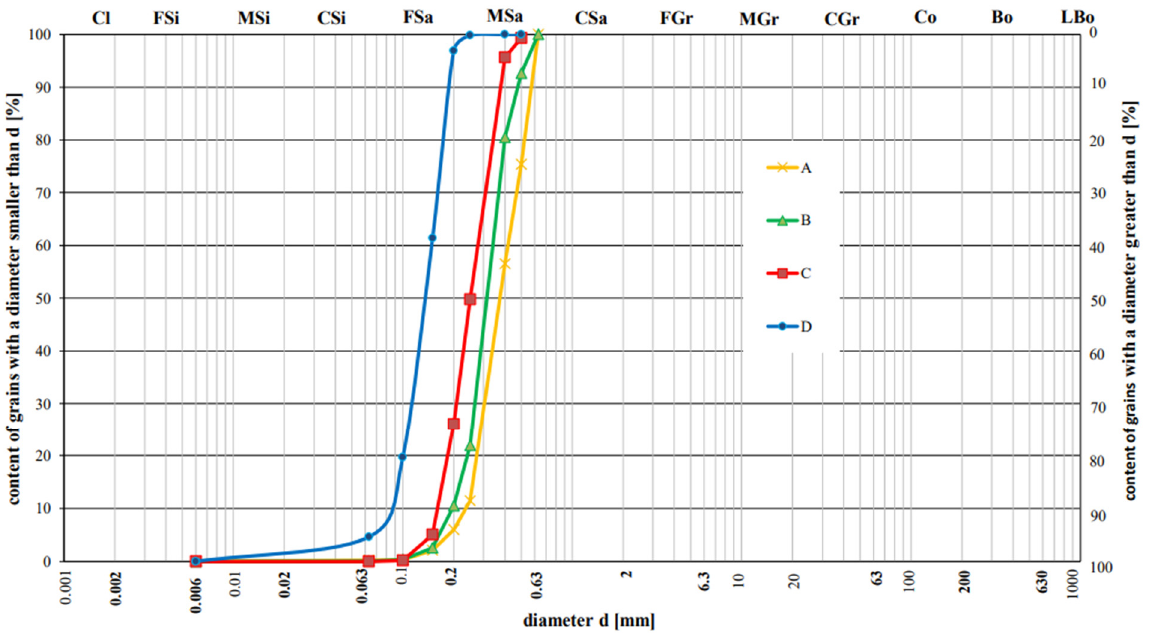
Figure 6. Grain size distribution of quartz sands used in the experiment A: d 50 = 0.38; B: d 50 = 0.32; C: d 50 = 0.25; D: d 50 = 0.14.